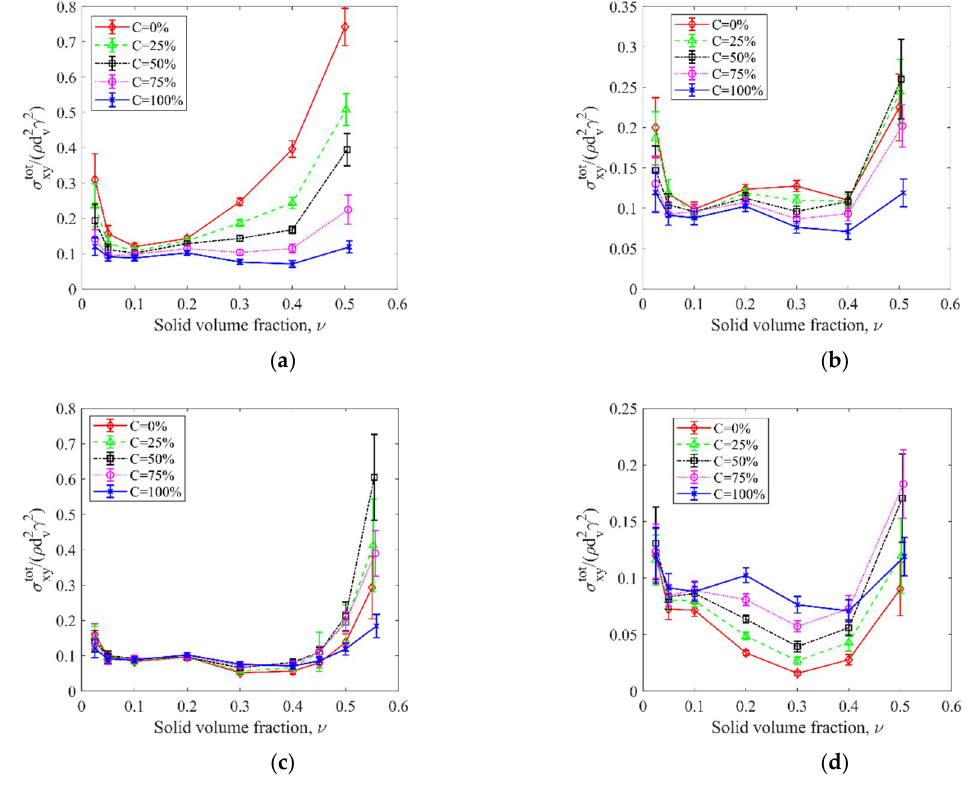
Figure 12. Average normalized shear stresses at the steady state for various binary mixtures with ( a ) AR = 0.3 and AR = 6, ( b ) AR = 0.2 and AR = 6, ( c ) AR = 0.15 and AR = 6, and ( d ) AR = 0.1 and AR = 6. An error bar represents the standard deviation of the stress from the average value at steady state.